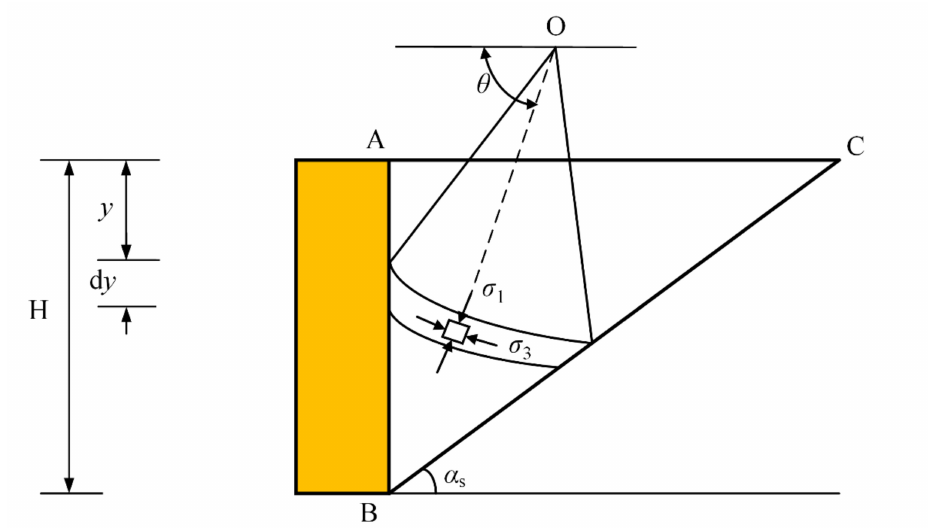
Figure 1. Schematic of soil behind retaining